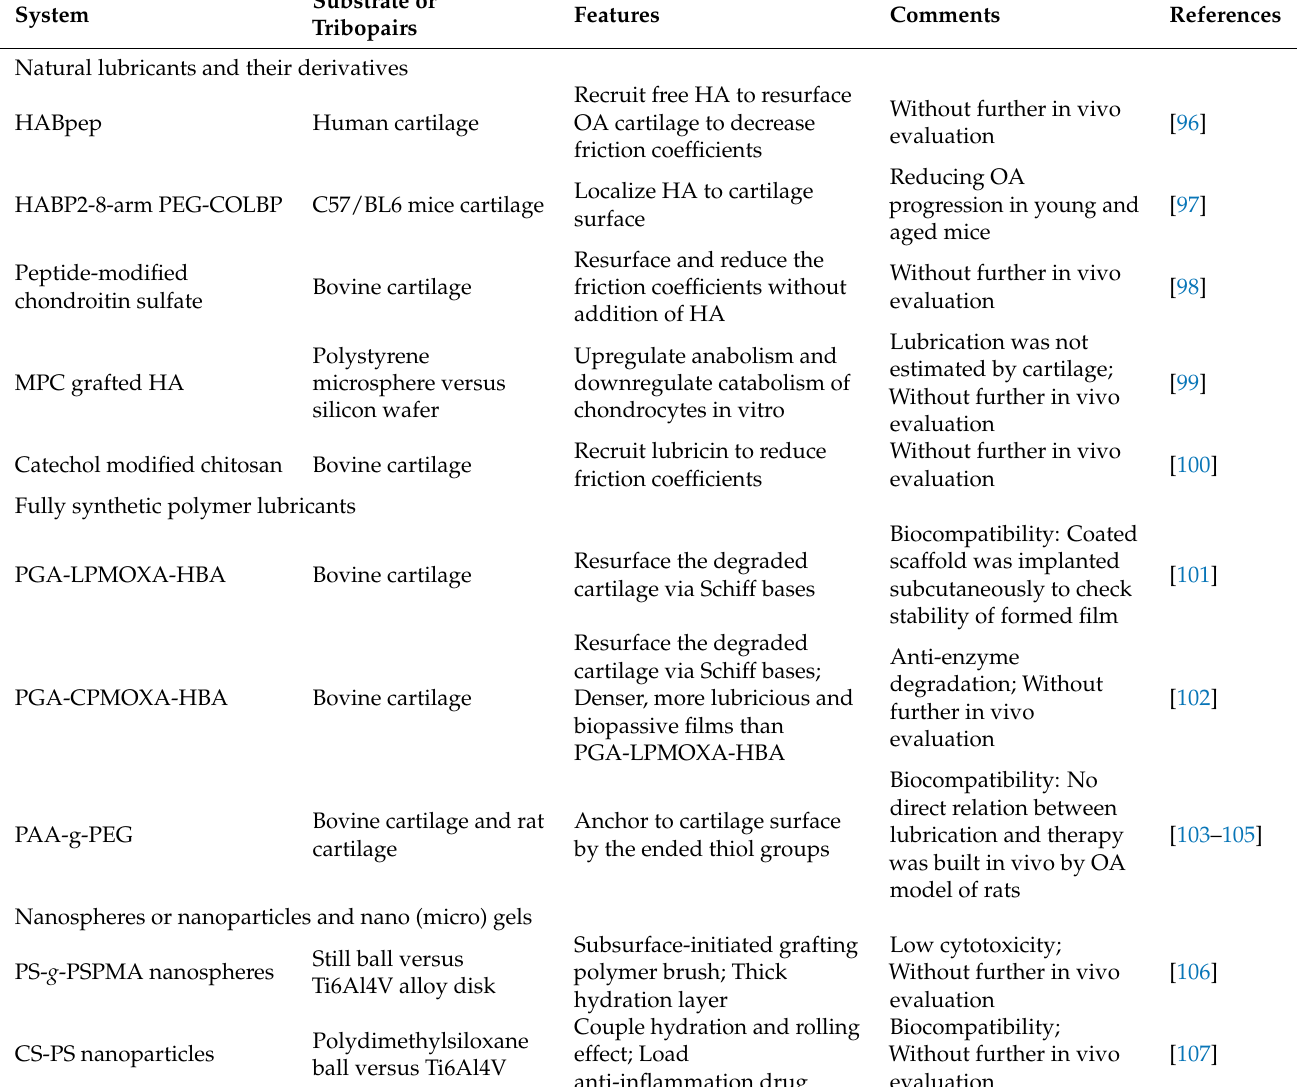
Table 2. Summary of typical biolubricants inspired by cartilage lubrication with the aim to treat OA. Substrate or System